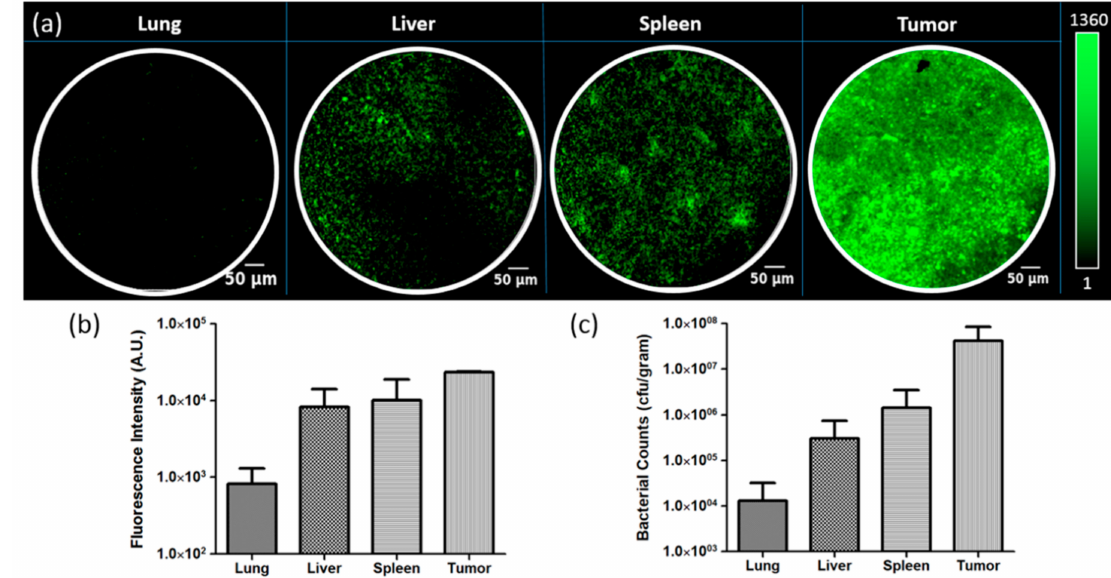
Figure 5. Ex vivo quantification of green fluorescent protein (GFP) bacteria in a mouse model with CFEM (n = 2). ( a ) Confocal fluorescence imaging of GFP bacteria in various extracted tissues from the orthotopic tumor mouse. ( b ) The quantified fluorescence signal of bacteria from each tissue. ( c ) Viable bacterial counting analysis of each extracted